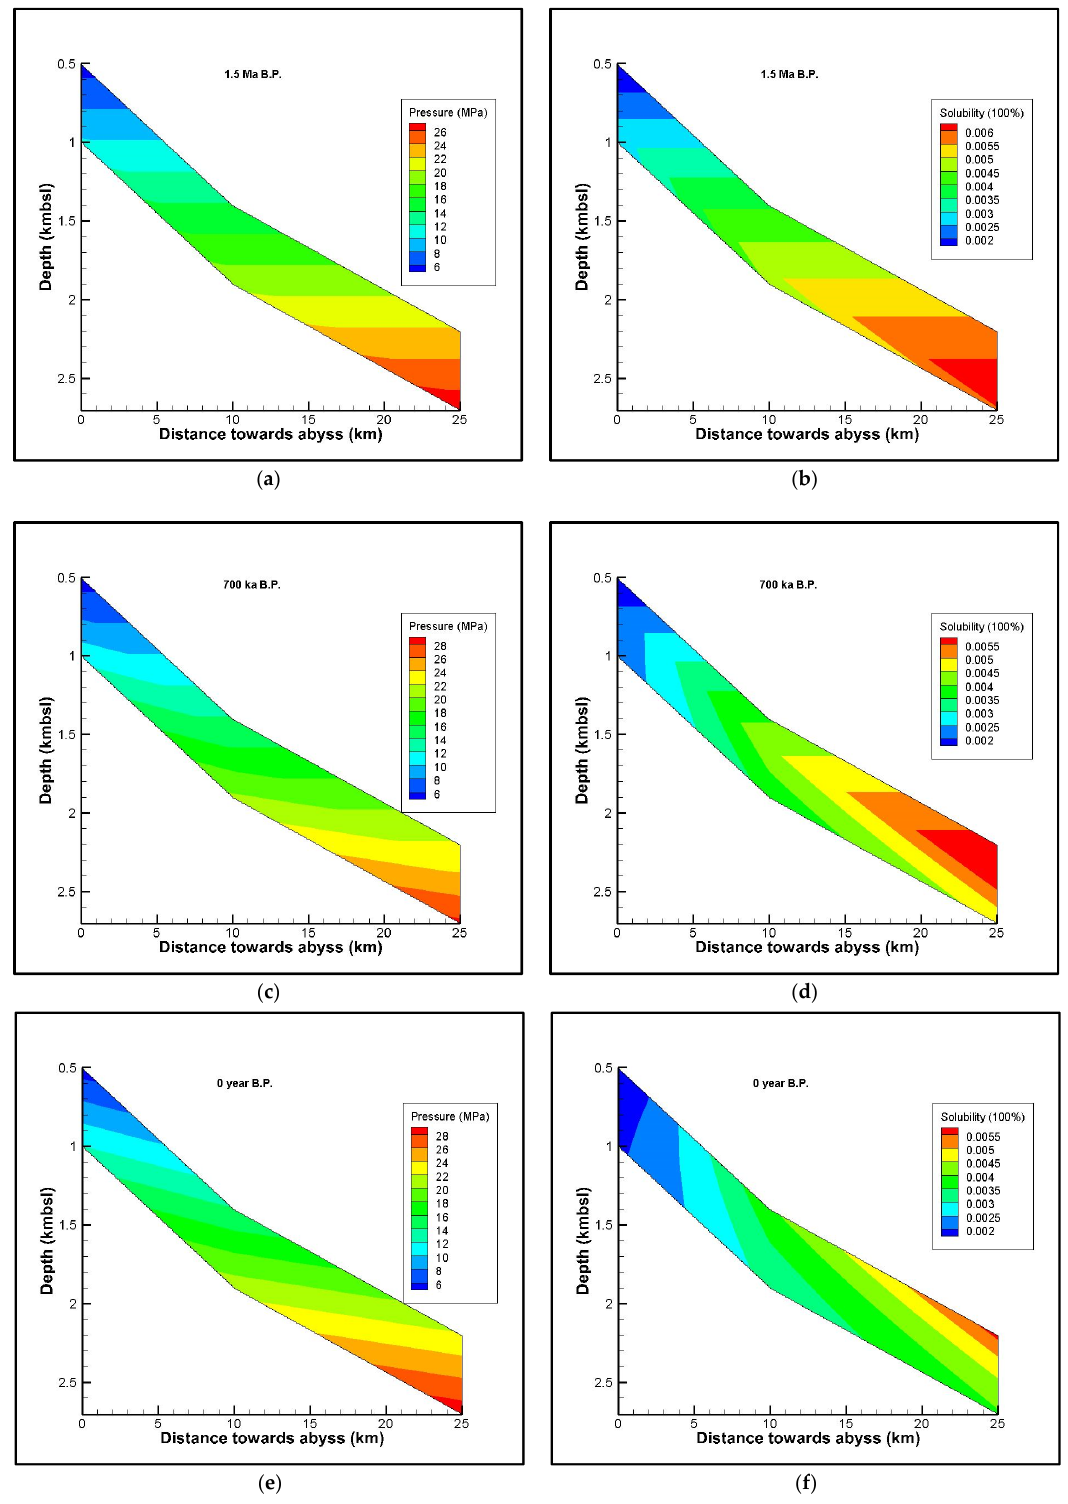
Figure 8. Changes in local pore pressure in the three selected scenarios of 1.5 Ma B.P. ( a ), 700 ka B.P. ( c ), and present ( e ), and corresponding gas solubility changes ( b , d , f ). Finally, we were able to investigate the conversion of this diffusive MH reservoir and the chloridion or salinity in the pore water—which are generally adopted as indicators of this system—along the slope surface seabed during the deposition process. In Figure 9a, when the sedimentation activity passed 300 ka since the beginning of the Pleistocene, MHs are produced in fresh thin sediments across the hypothetical baseline. At this moment, the slope foot had a maximum MH of about 0.022, where the salinity was about 0.0366 (Figure 9b). When this process continued to evolve to 700 ka B.P., the MH peak reached 0.09 (Fig- ure 9c), where the salinity was 0.048 (Figure 9d). In contrast with these two scenarios, when the time reached the present, the distribution of the MHs was closer to the current seafloor (Figure 9e). It is very clear that the previous MH-bearing layers disappeared, while a group of MH-bearing layers appeared close to the foot area of the slope. The max- imum MH concentration within these sediments was about 0.097, with its location being 310 mbsf. The increasing salinity at this position reached its maximum, about 0.051 (Figure 9f). In this investigation, the accumulation conditions of the MH reservoir looked better than before, as the MH became more and more abundant, concentrated, and was more widely distributed.